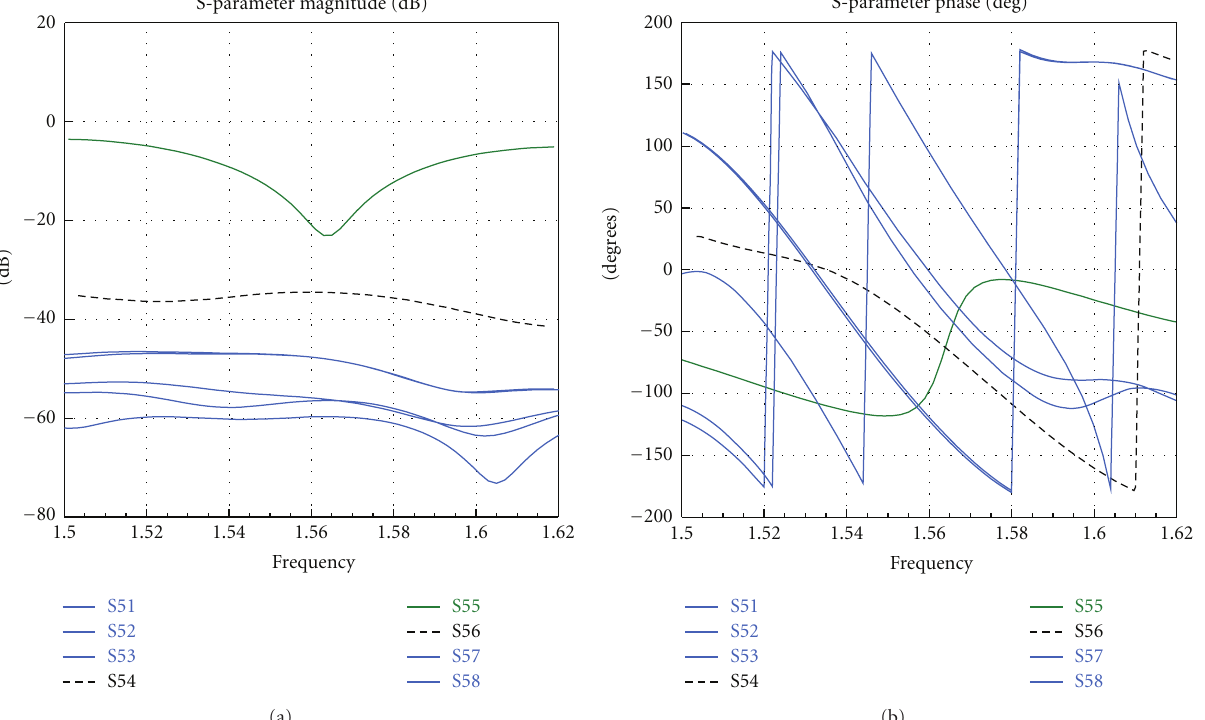
Figure 3: S-parameter matrix in (a) magnitude (dB) and (b) phase